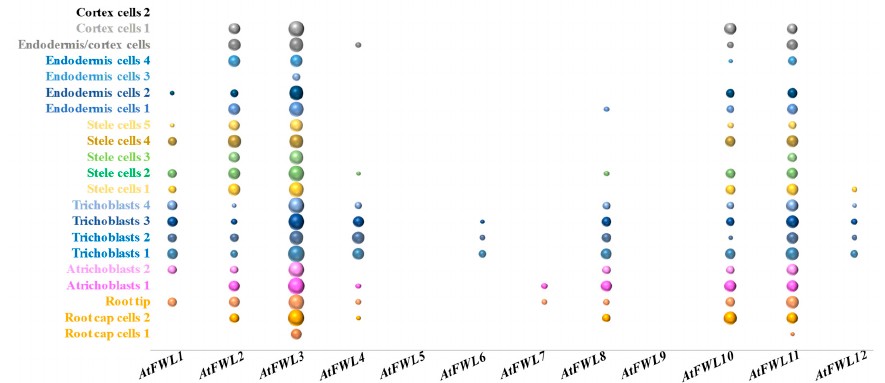
Figure 2. Expression level of the 12 Arabidopsis thaliana FWL / CNR genes in various root cell types. Each dot represents the log10-transformed expression levels of each AtFWL / CNR genes across 21 di ff erent cell cluster / cell type. Each cell cluster / cell type is represented by a di ff erent color. Root single-cell expression datasets were mined from Ryu et al., 2019 [65].